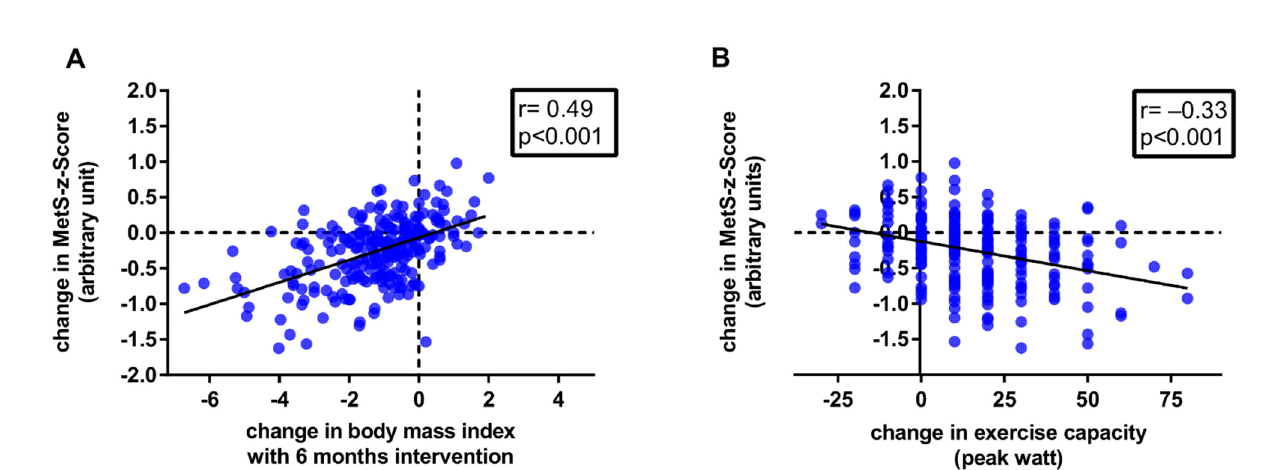
Figure 2. 6-month intervention induced changes in MetS severity (MetS-z-Score) in correlation with Figure 2. 6 ‐ month intervention induced changes in MetS severity (MetS ‐ z ‐ Score) in correlation with changes in BMI ( A ) and changes in absolute exercise capacity ( B ). changes in BMI ( A ) and changes in absolute exercise capacity ( B